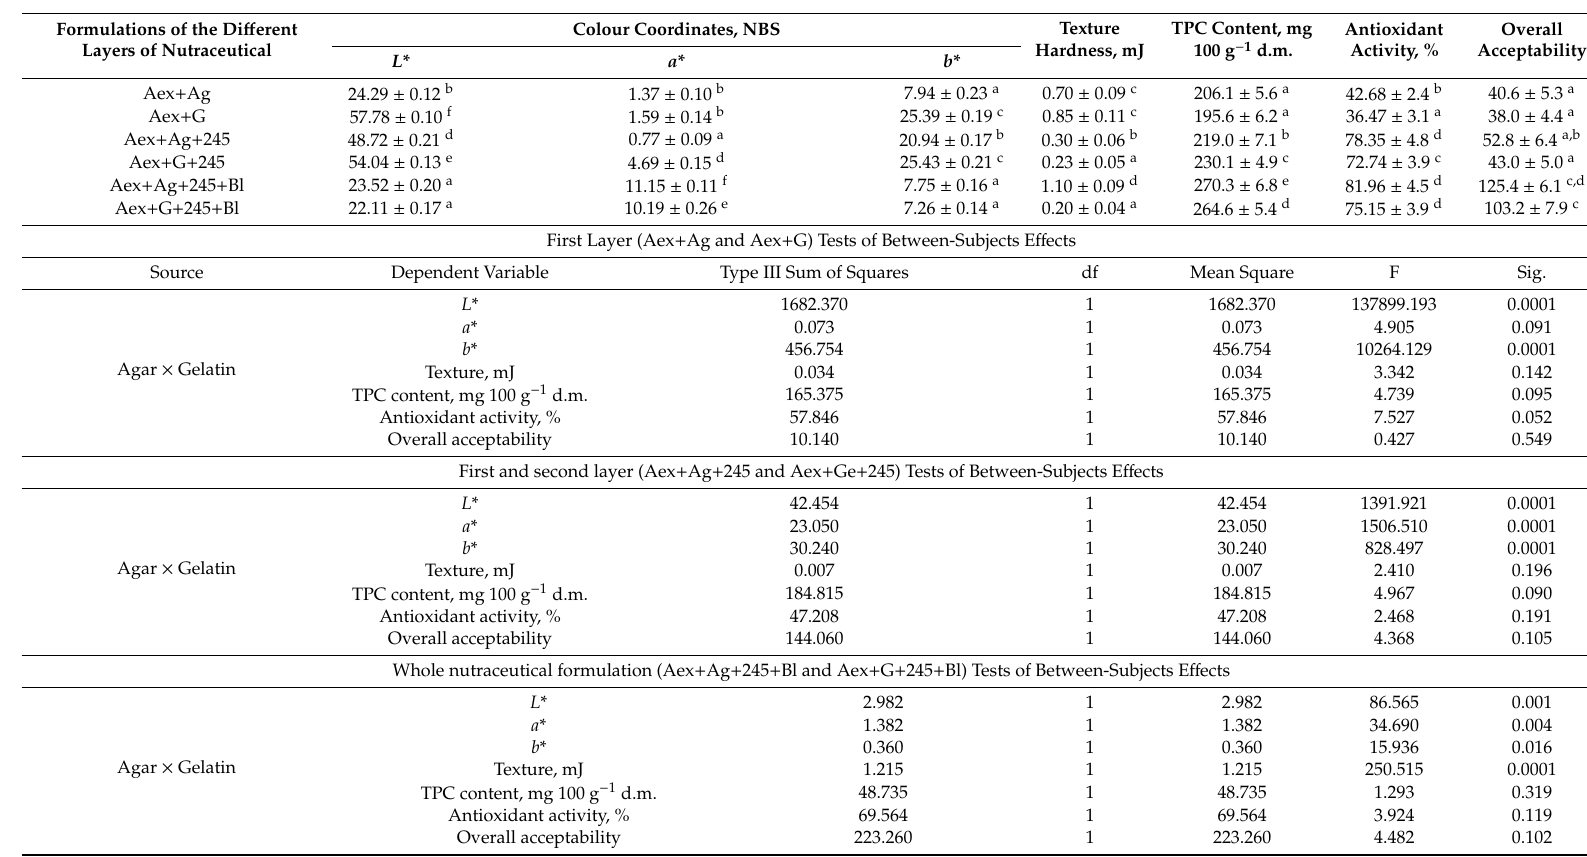
Table 4. Nutraceuticals colour coordinates (NBS), texture (mJ), total phenolic compounds content (mg 100g − 1 d.m.), antioxidant activity (%), and overall acceptability (from 140 – extremely like to 0 – extremely